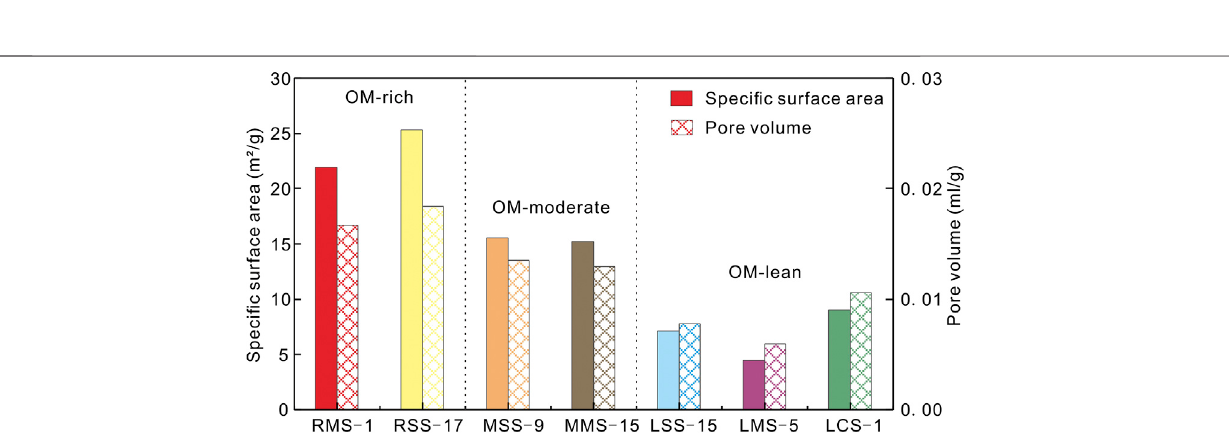
FIGURE 5 | Speci fi c surface areas and pore volumes of the Longmaxi Formation shale from N 2 adsorption. OM-rich mixed shale (RMS); OM-rich siliceous shale (RSS); OM-moderate mixed shale (MMS); OM-moderate siliceous shale (MSS); OM-lean mixed shale (LMS); OM-lean siliceous shale (LSS); OM-lean clay shale (LCS).